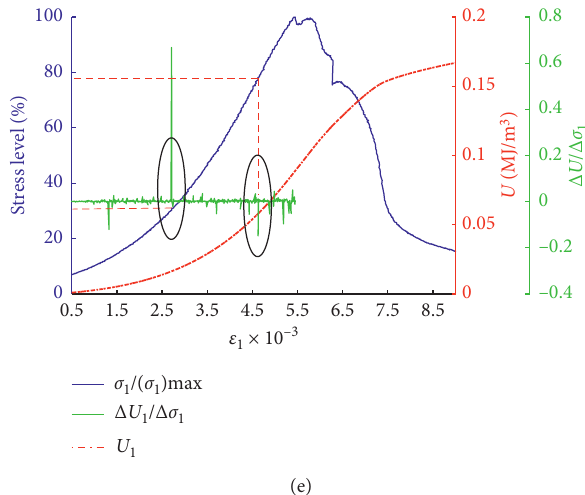
Figure 8: Evolution curve of the increment ratio of strain energy to axial pressure. (a) 25 ° C, (b) 200 ° C, (c) 400 ° C, (d) 600 ° C, and (e) 800 ° C.